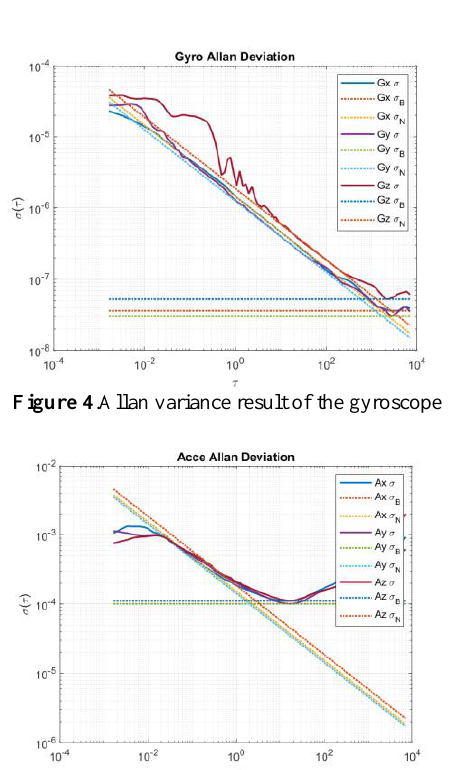
Figure 5. Allan variance result of the accelerometer